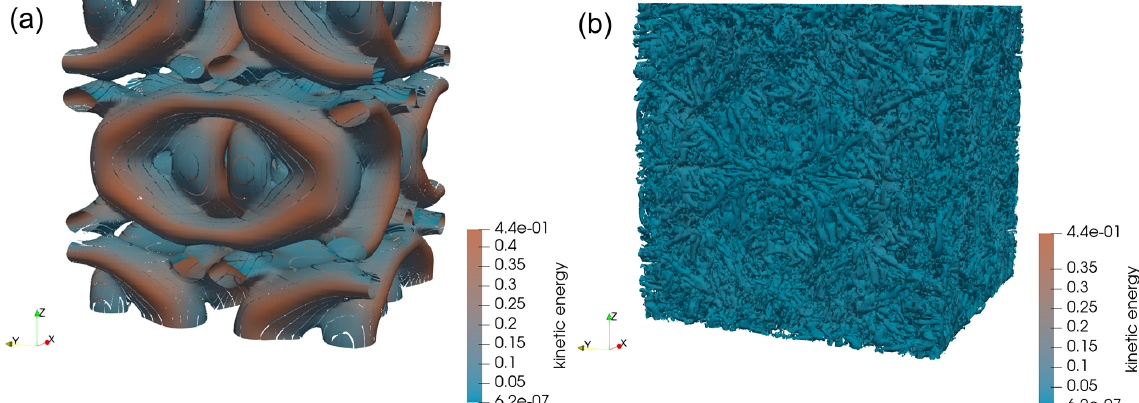
Figure 7. Taylor–Green vortex. Isosurfaces of zero Q-criterion (these identify surfaces where the vorticity norm is identical to the strain rate magnitude) on a 192 3 grid, corresponding to 48 elements of order 4 at (a) t ∗ = 4 and (b) t ∗ = 60. Plots are shown for the Vreman solution. The isosurfaces of the Q-criterion are colored by dimensionless kinetic energy.